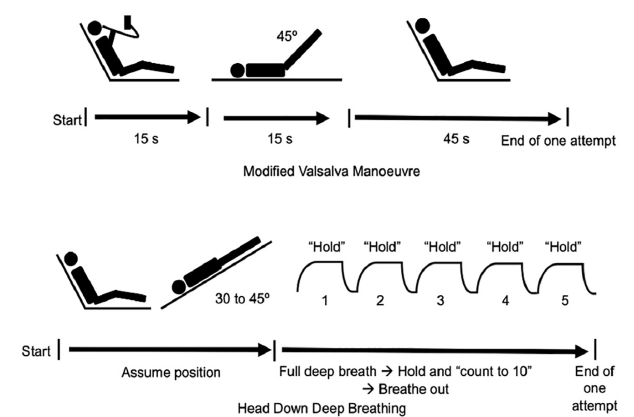
Figure 1. Modified Valsalva manoeuvre and head down deep breathing